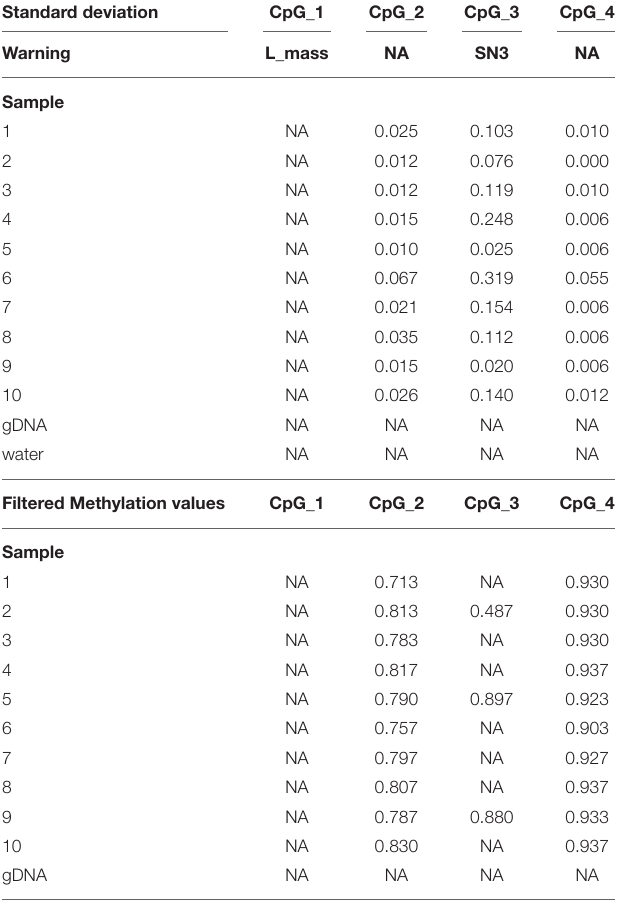
TABLE 5 | Results for the LEP amplicon measurement. Standard